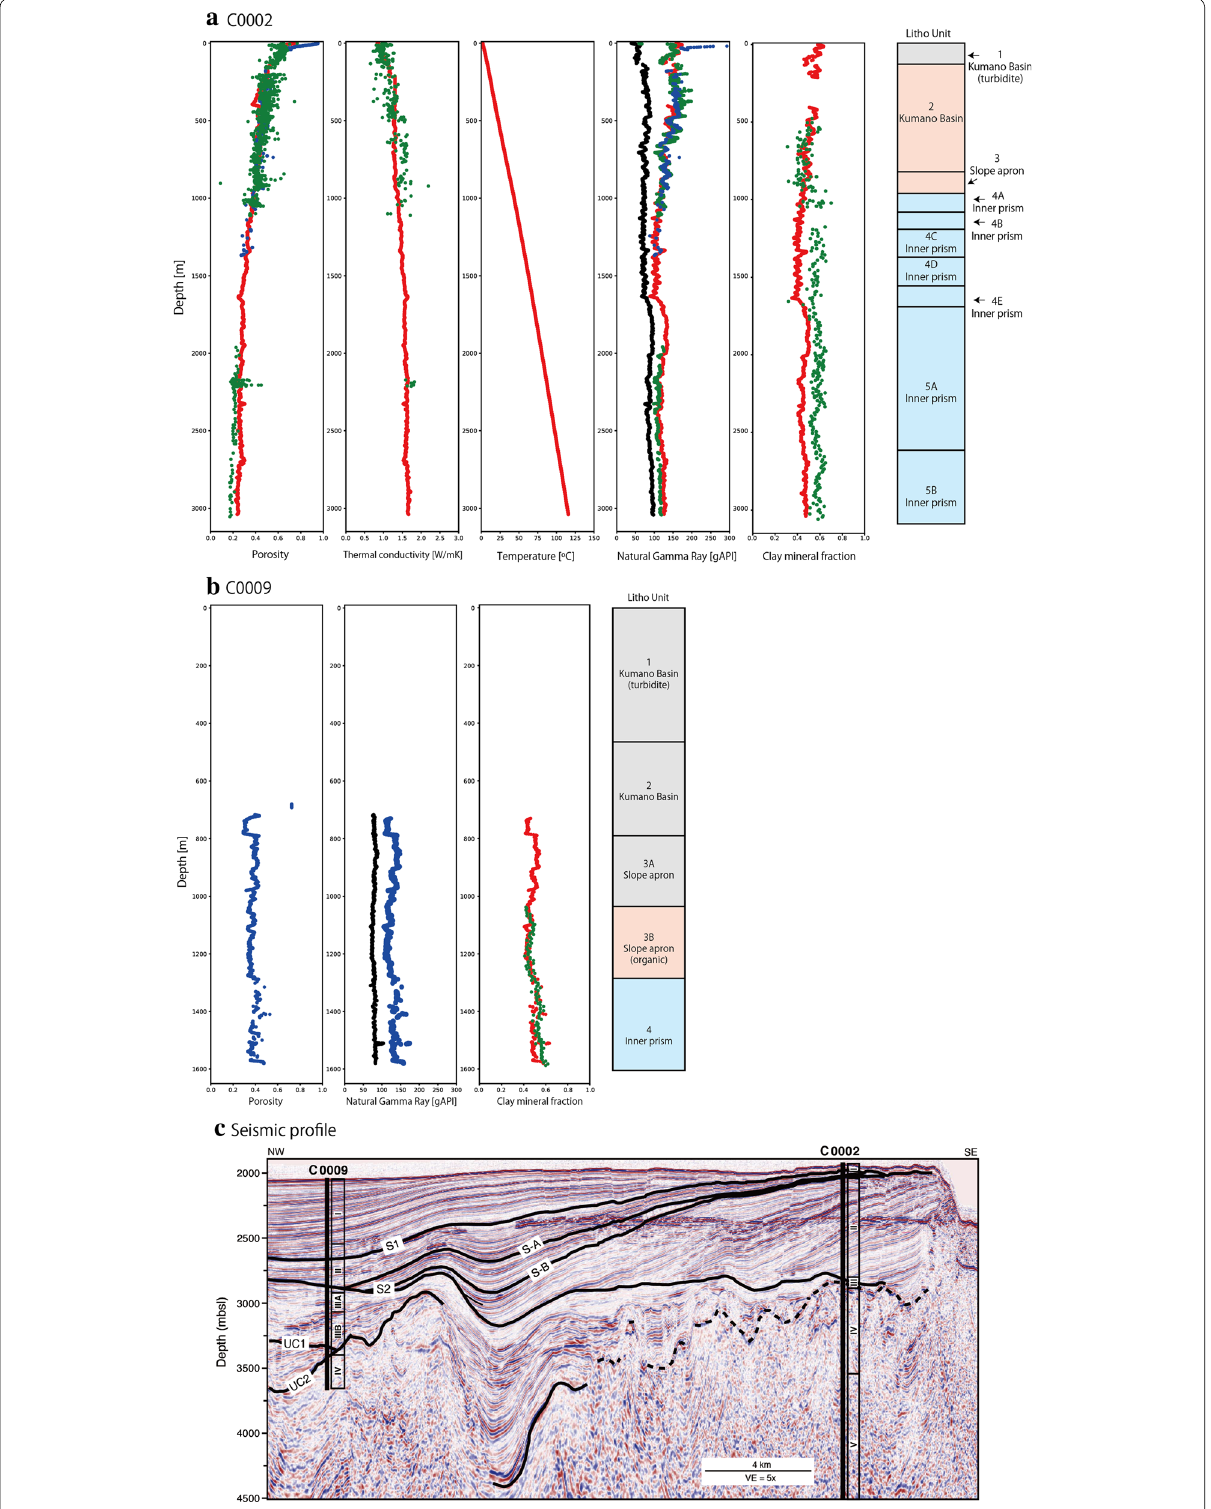
Fig. 6 Data from the Kumano Basin sites. a Site C0002, b site C0009, and c a seismic profile around the Kumano Basin after Figure F116 of Expedition 319 Scientist (2010a). Symbols are the same as those in Figs. 2 and 5. Lsithological units colored by light blue represent the inner prism sediment below the Kumano Basin, which shows lower NGR log values than the standard sediments possibly due to poor hole